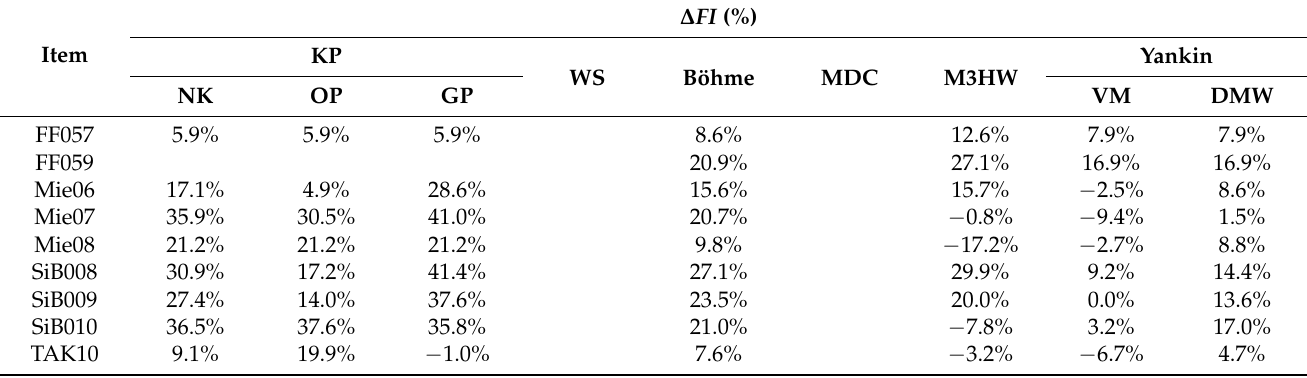
Table 9. The response of the new multiaxial fatigue strength criteria evaluated to load cases from the AMSD25 data set including pressurizing. The void cells mark the load cases, which the criteria are not able to process.